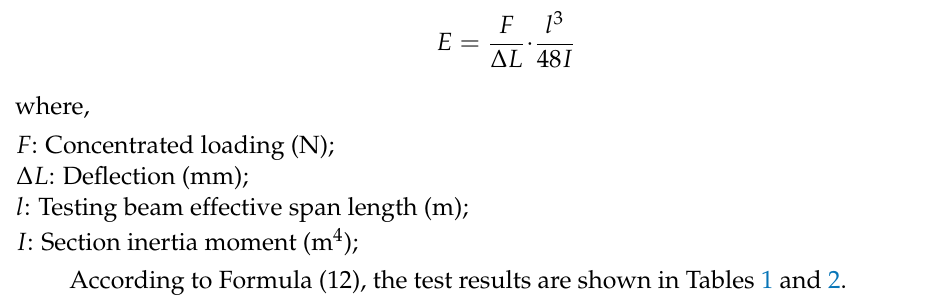
Table 1. Elastic modulus of testing beam.